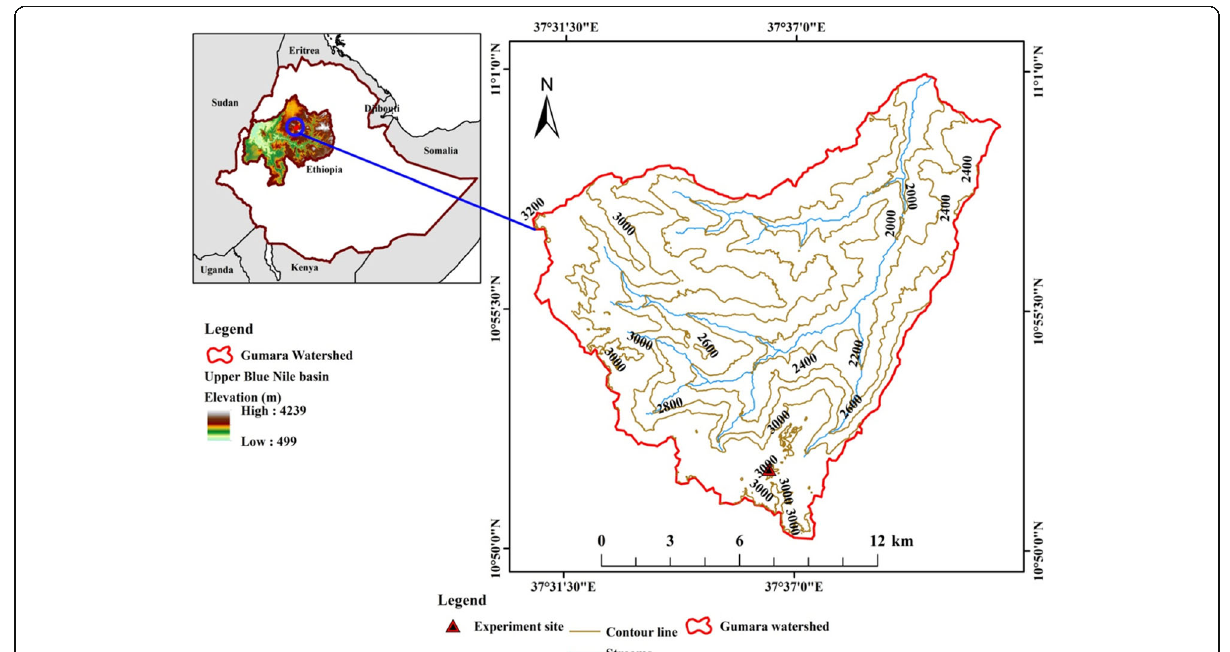
Fig. 1 Experimental erosion plots site in Gumara watershed, Upper Blue Nile basin,